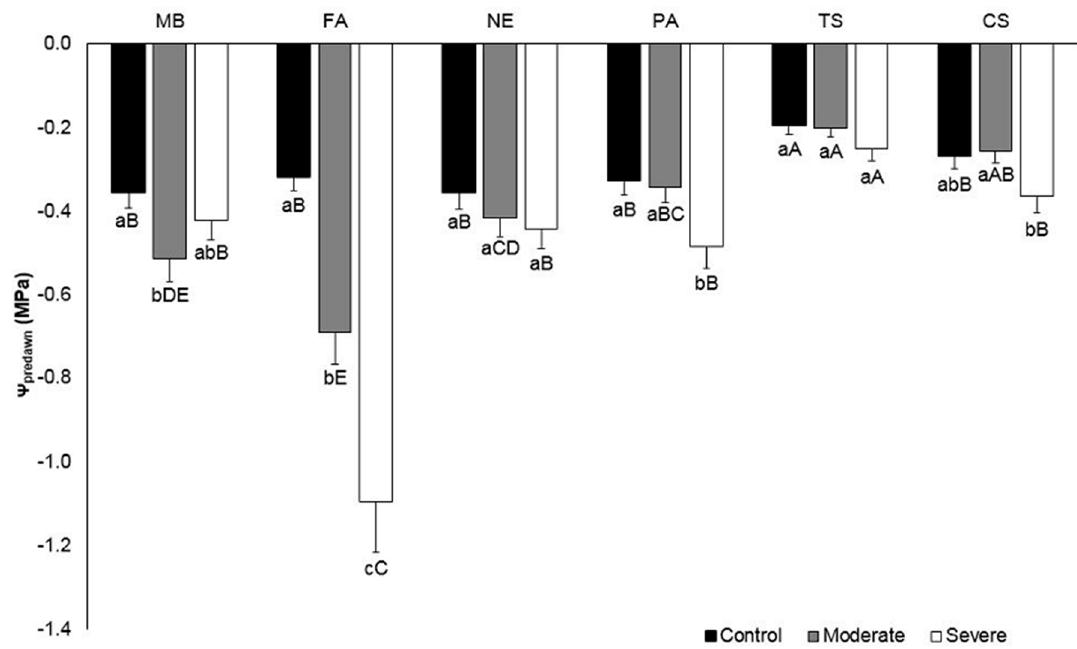
Figure 2. Median values of predawn leaf water potential ( Ψ pd ) of six table grape cultivars subjected to three water deficit treatments at harvest in 2016. The data represent values of back transformed data.